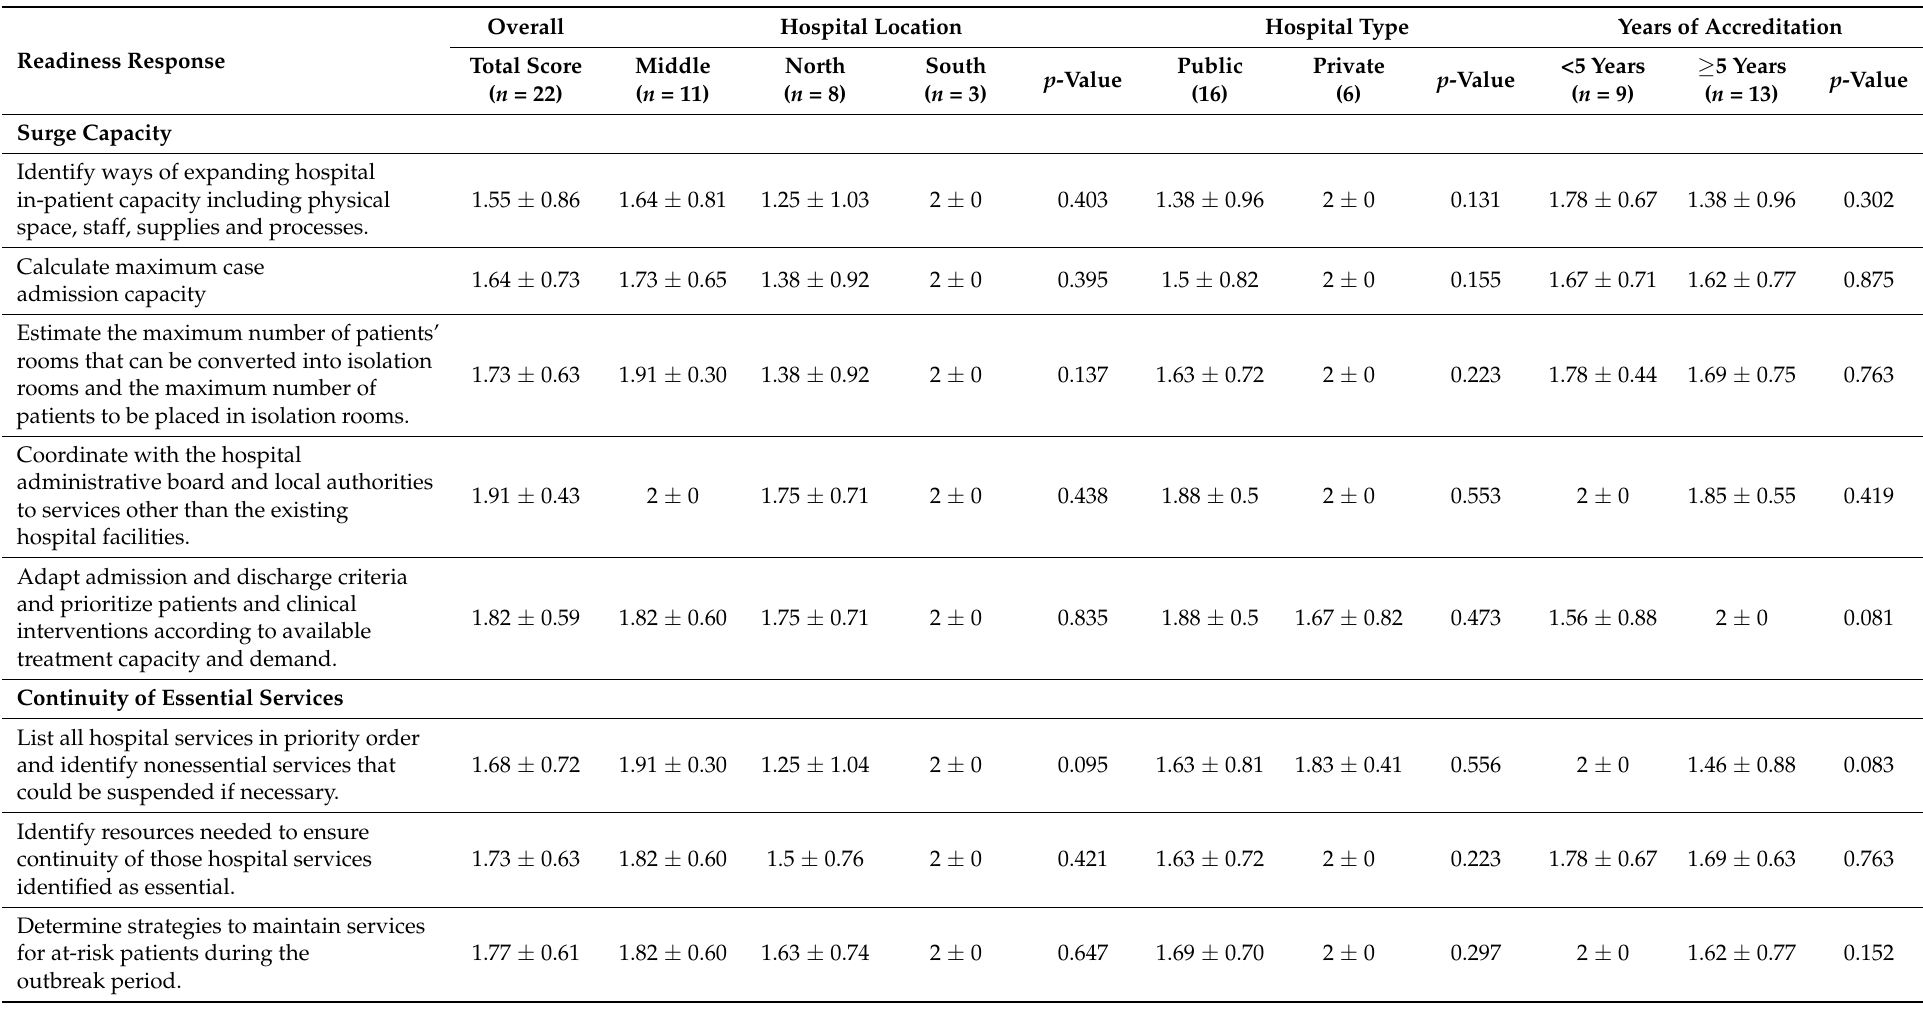
Table 6. Detailed average compliance score of participating hospitals according to response function stratified according to hospital location, type, and years of accreditation for response functions (Surge Capacity, Continuity of Essential Services, Rapid Identification, and